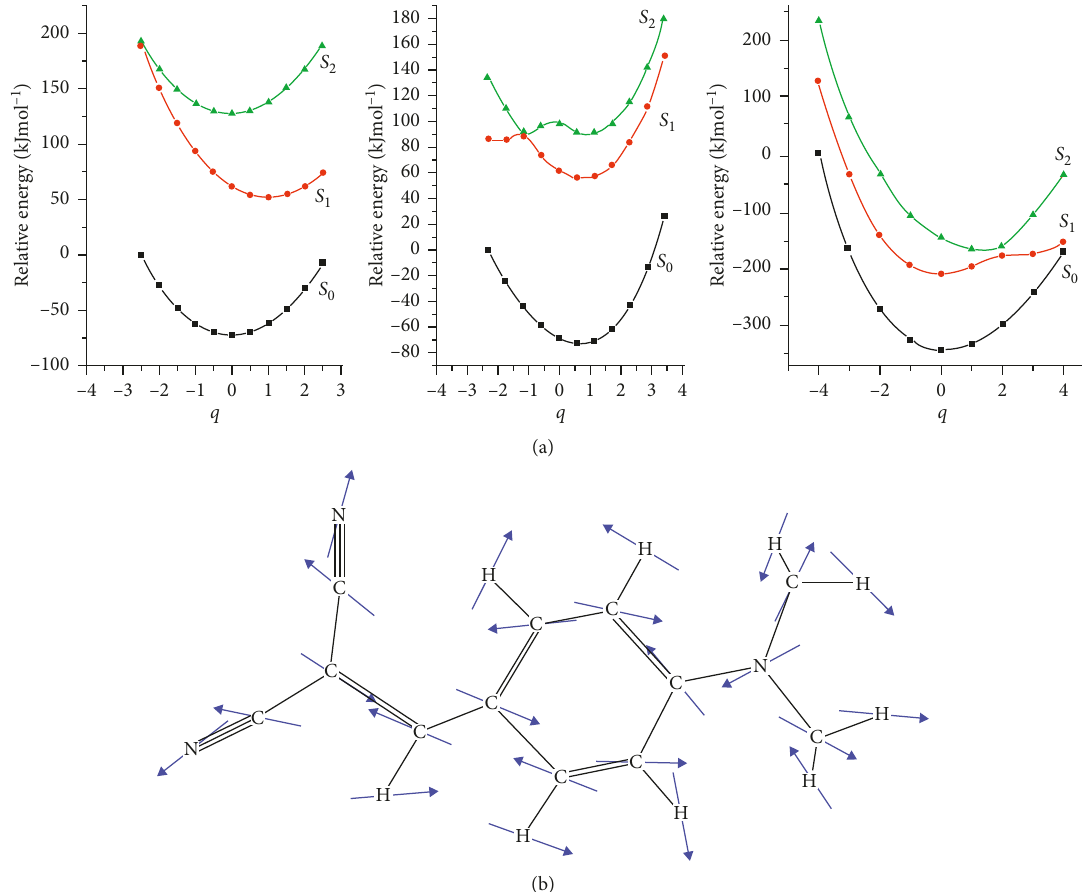
Figure 12: PESs scanned along some IR normal coordinate modes in the ground state (a) shows PESs of ground and the first two excited singlet states scanned along the displacement coordinate (q) due to different IR modes (from the left to right): mode 63 (at 1597cm − 1 mainly due to D-, S1-, and S2-bond vibration), mode 64 (at 1633cm − 1 due to D- and S2-bonds), and mode 65 (at 1682.8cm − 1 mainly due to D-bond vibration), respectively. (b) An example of most important mode 65 visualizing the displacement vibrational vectors (shown as arrows) involved in the dynamical motions due to the molecular